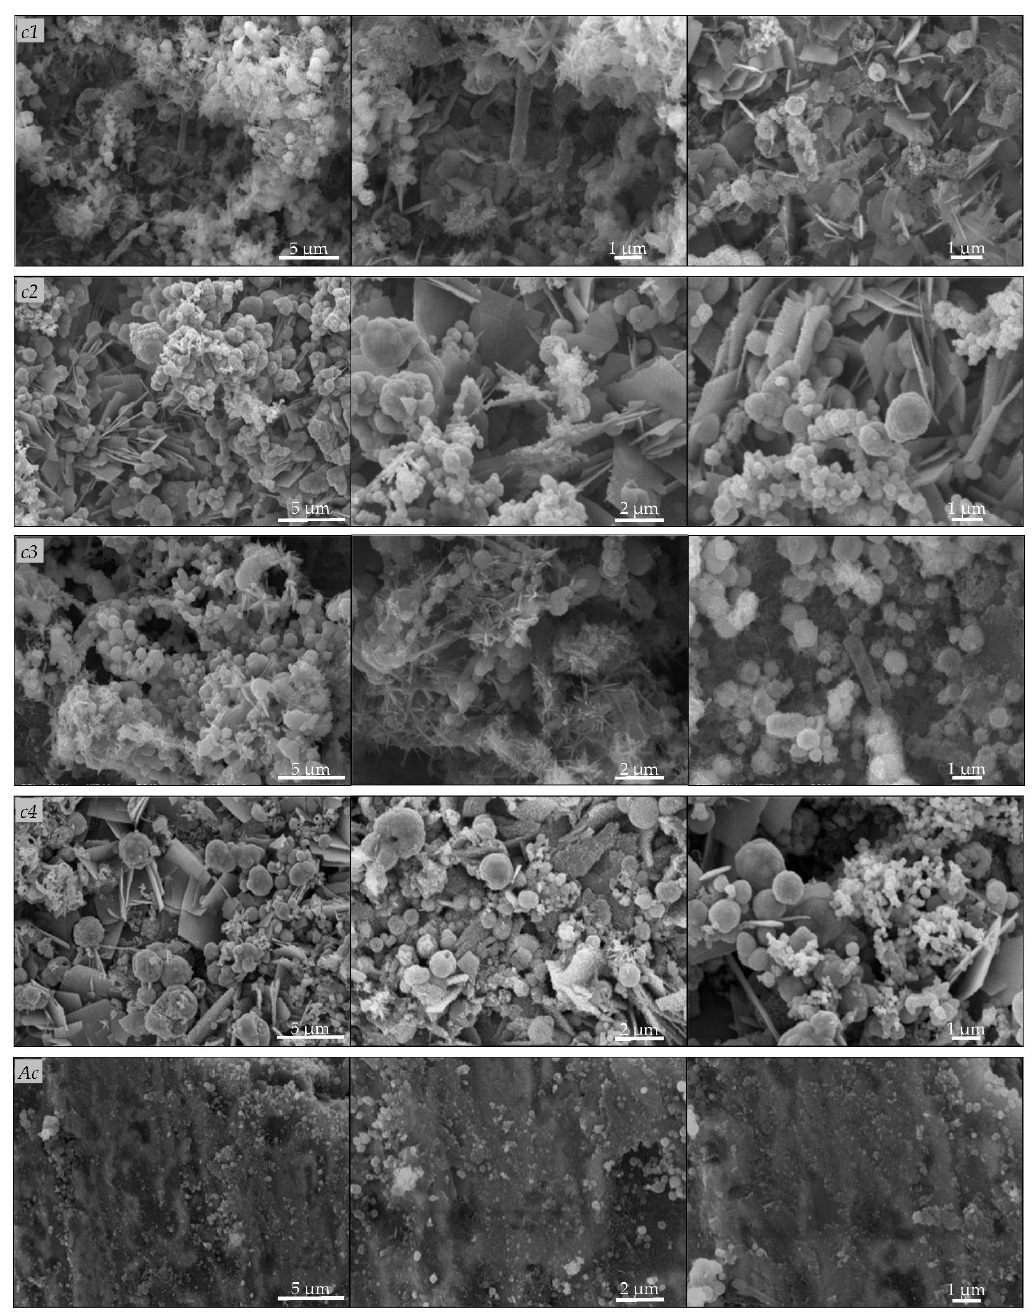
Figure 4. Scanning electron microscopy observation of carbon steel coupons before removal of biofilm and corrosion products. Carbon steel A570 ( c1 , c2 ), 1045 ( c3 , c4 ) coupons immersed in the water sample and incubated for 120 days under aerobic ( c1 , c3 ) or anaerobic ( c2 , c4 ) conditions; abiotic controls ( Ac ).